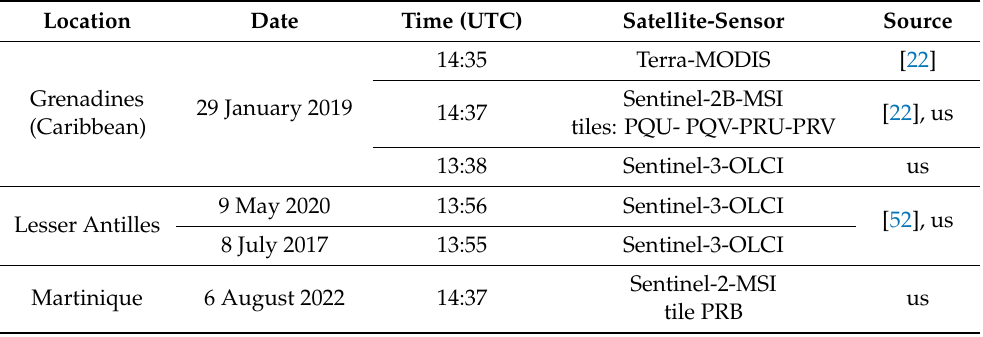
Table 1. Images of the focus dataset used to evaluate the performance of our CNNs compared to images from the literature, with a summary of their characteristics: location, acquisition date and time, satellite, and sensor. The ‘Source’ column indicates the source of each image: a reference for images taken from the literature, and ‘us’ for images processed with our own CNN